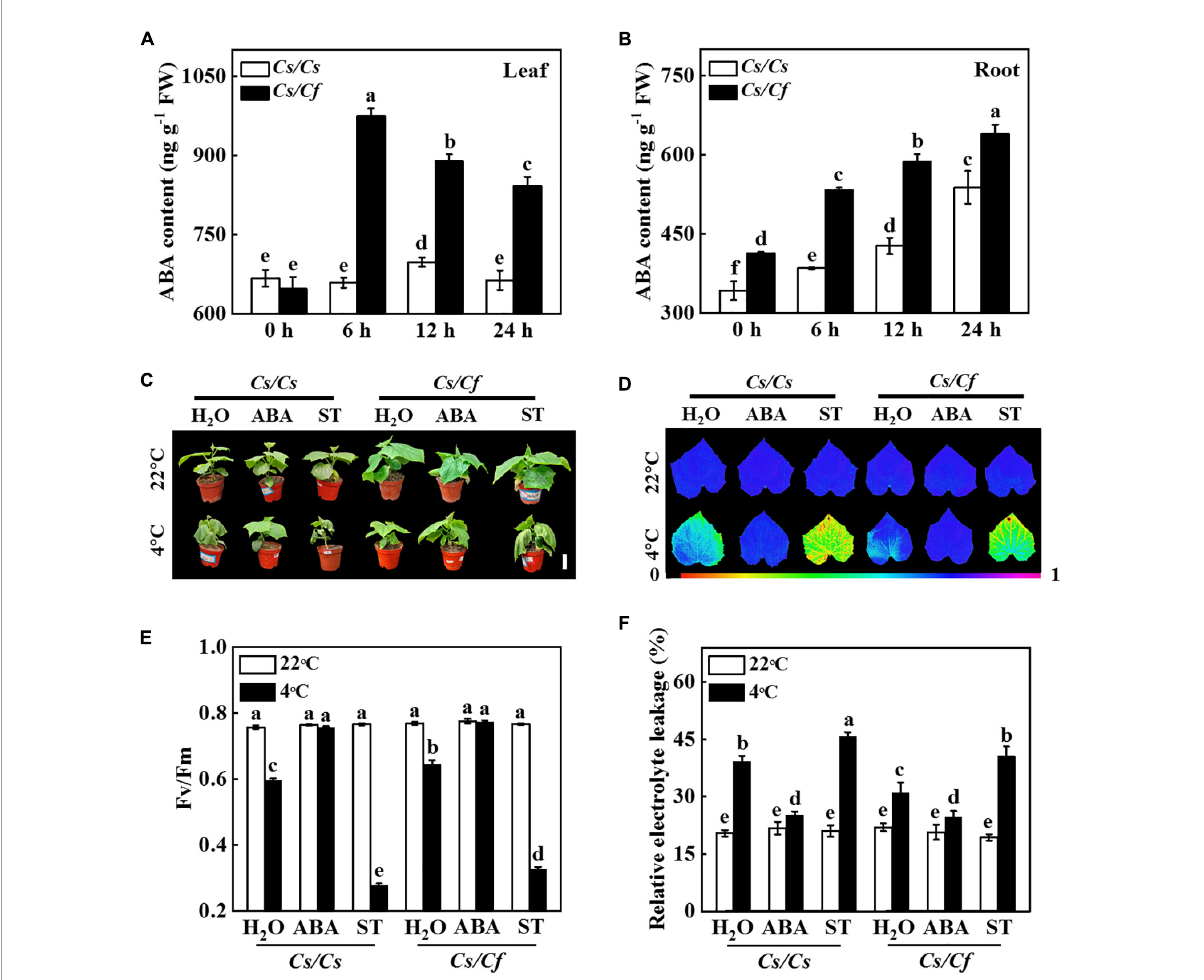
FIGURE7 Abscisic acid (ABA) mediates figleaf gourd-induced cold stress tolerance. (A) ABA content in the leaves of grafted plants. (B) ABA content in the roots of grafted plants. Cucumber seedlings grafted onto cucumber ( Cs/Cs ) and figleaf gourd ( Cs/Cf ) were treated with cold stress at 4 ◦ C, and the leaves or roots were harvested at the indicated time points for analysis ABA content. (C) Phenotype of grafted plants treated with ABA or sodium tungstate (ST) under cold stress. (D,E) The maximum quantum yield of photosystem II (Fv/Fm) of grafted plants treated with ABA or ST under cold stress. (F) Relative electrolyte leakage (REL) of grafted plants treated with ABA or ST under cold stress. The Cs/Cs and Cs/Cf plants were irrigated with 100 µ mol ABA or 1 mmol ST for 24 h, and then the plants were exposed to 4 ◦ C for 7 d to analyze the phenotype, Fv/Fm, and REL. The results represent the mean ± SD ( n = 3). Means with the same letter did not significantly differ at P < 0.05 according to Tukey’s test. FW, fresh